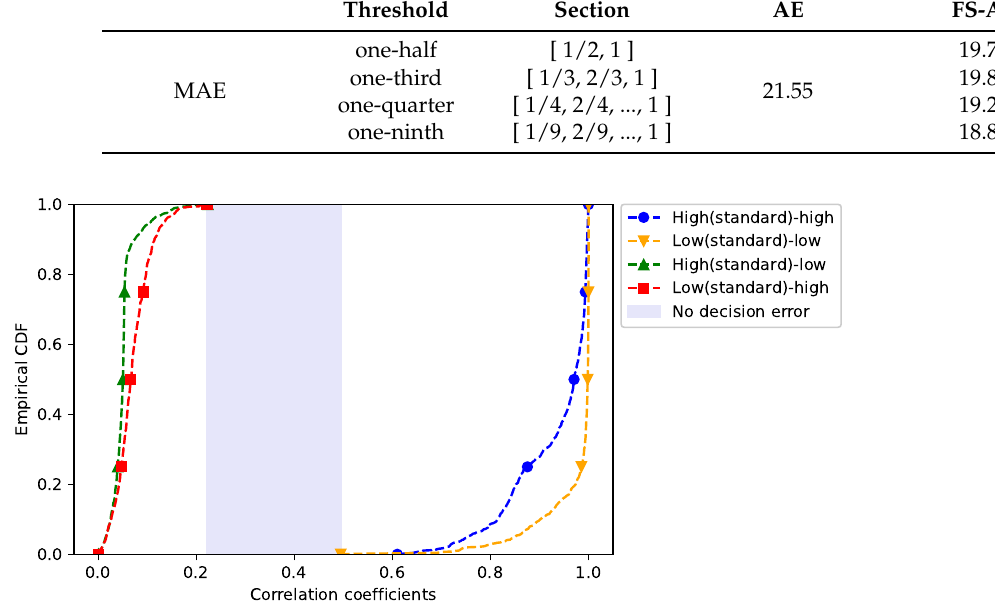
Figure 9. Cumulative distribution function (CDF) plot for setting the decision boundary, based on the correlation coefficients in the decoder selection.